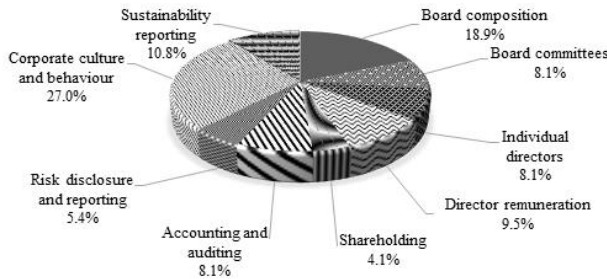
Figure 1: Contribution of the corporate governance categories to the total CGS (a) (a) The 9 categories comprised 39 recommendations. Details could not be provided due to a confidentiality agreement.